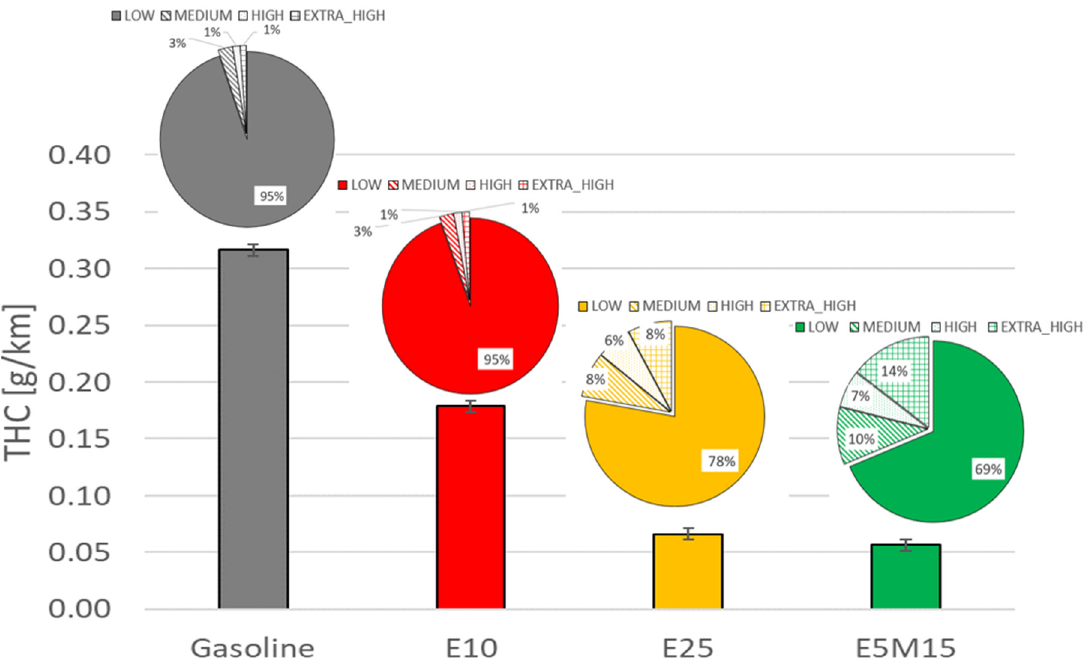
Figure 7. THC emissions measured at each phase of the cycle for gasoline, E10, E25 and E5M15.